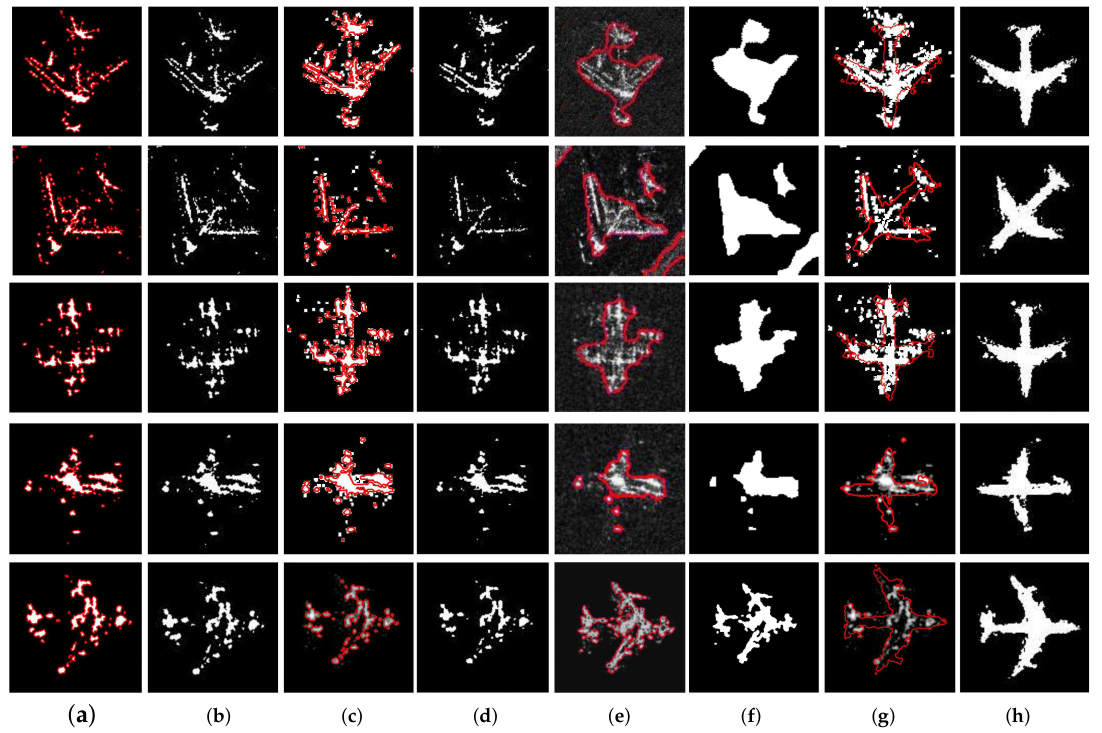
Figure 13. Comparison of reconstruction results of different methods. ( a , b ) Reconstruction results of the graph cut method; ( c , d ) Reconstruction results of our method without the shape term. ( e , f ) Reconstruction results of Chan-Vese segmentation method. ( g , h ) Reconstruction results of our